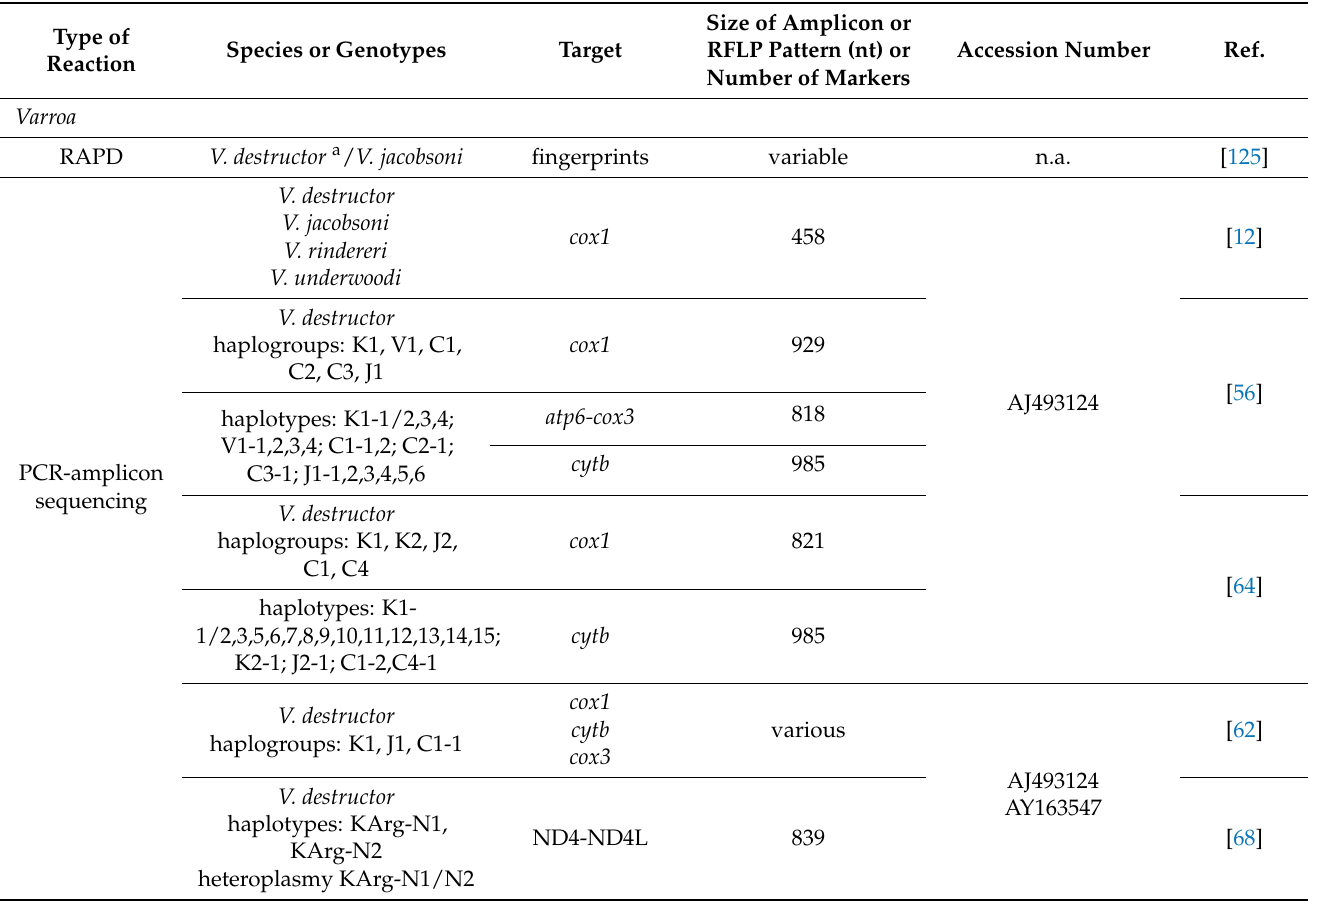
Table 1. Molecular diagnostics for detection and inter- and intra-species differentiation of arthropods pathogenic for the